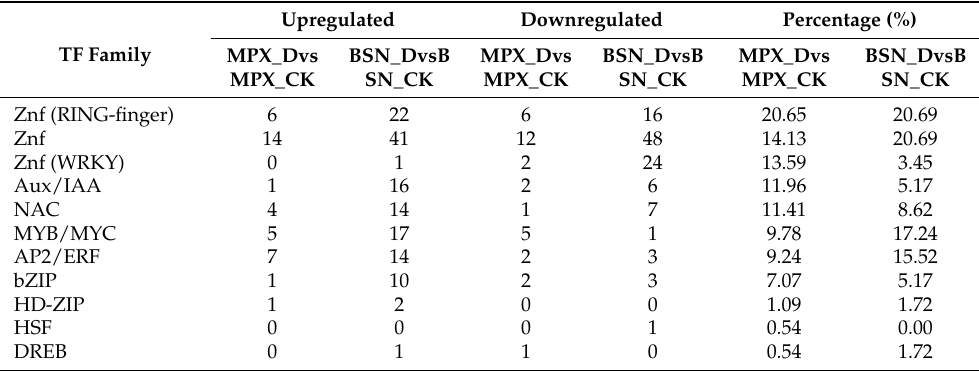
Table 3. Transcription factors related to drought stress in Shanlan upland rice varieties.